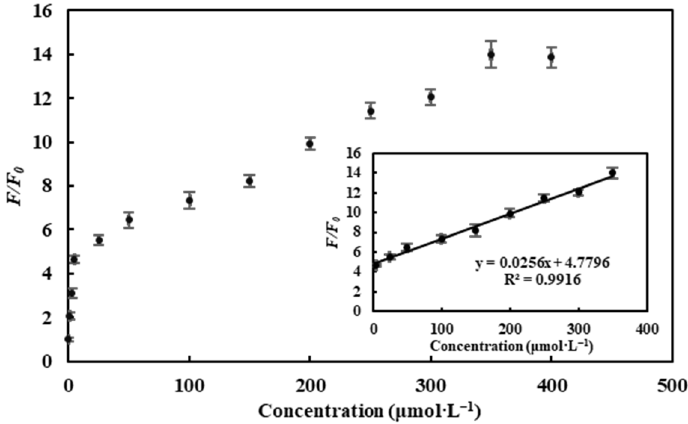
Figure 9. The plot of the fluorescence recovery factor ( F/F 0 ) versus concentrations of ascorbic acid (inset: a linear region).